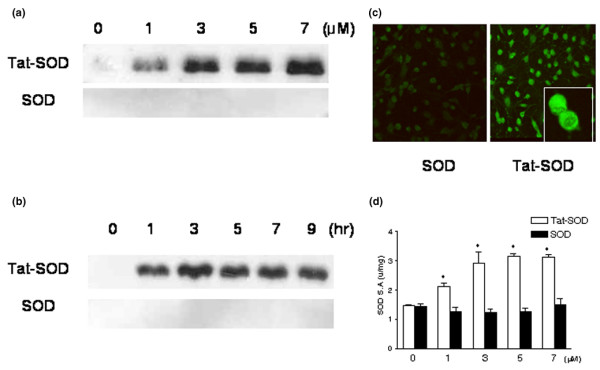
Transduction of transactivator of transcription (Tat)-superoxide dismutase (SOD) fusion protein into monolayer cultured chondrocytes. Chondrocytes were obtained from the femoral condyle and the tibial plateau from osteoarthritis (OA) patients and cultured in monolayers. First passage chondrocytes were used in subsequent experiments. (a) Dose-dependent and (b) time-dependent transduction of Tat-SOD into chondrocytes. Transduction of Tat-SOD into the cells was analyzed by western blotting with a rabbit anti-polyhistidine IgG. Tat-SOD (1 to 7 μM) and control SOD were added to the culture medium for 1 hour (a), or 3 μM of Tat-SOD and control SOD were added to the culture medium for 1 to 9 hours (b). (c) Localization of transduced Tat-SOD protein. After FITC-labeled Tat-SOD (3 μM) was transduced into chondrocytes, the cells were washed with PBS and immediately observed by fluorescence microscopy (×100 original magnification; inset, ×400 original magnification). Data are representative of four samples from different donors. (d) The specific activities of SOD in cultured chondrocytes treated with Tat-SOD; 1 to 7 μM of Tat-SOD and control SOD were added to the culture medium for 1 hours. Bars represent the mean ± standard error of the mean obtained from duplicate experiments from three donors. Asterisks denote p < 0.05 compared to control.